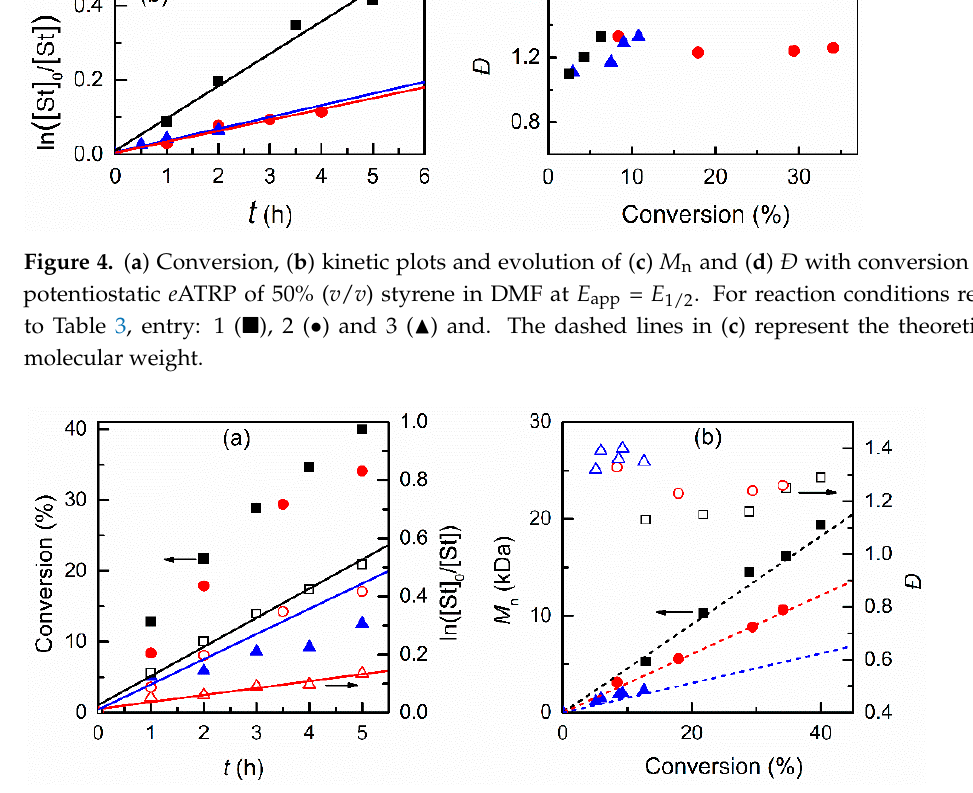
Figure 5. ( a ) Kinetic plots and ( b ) evolution of M n and Ð with conversion for potentiostatic e ATRP of styrene in DMF at St/DMF (v/v) = 75/25 (squares), 50/50 (circles) and 25/75 (triangles); other conditions: [St]:[EBiB]:[Catalyst] = x :1.5:0.1, where x = 654, 435, and 218; [Cu II ] = 10 − 3 M; E app = E 1/2 ; T = 80 °C. The dashed lines in ( b ) represent the theoretical molecular weights.